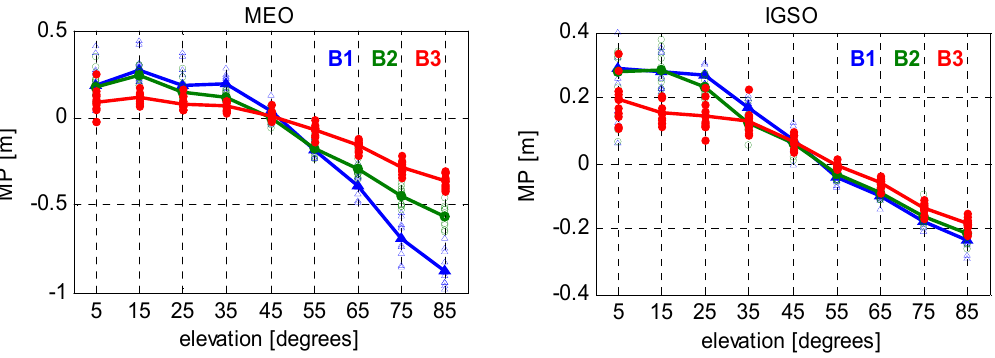
Figure 4. Piecewise linear MP models for BeiDou MEO ( left ) and IGSO satellites ( right ) on JFNG station using data from different days (during January 2014–October 2015).